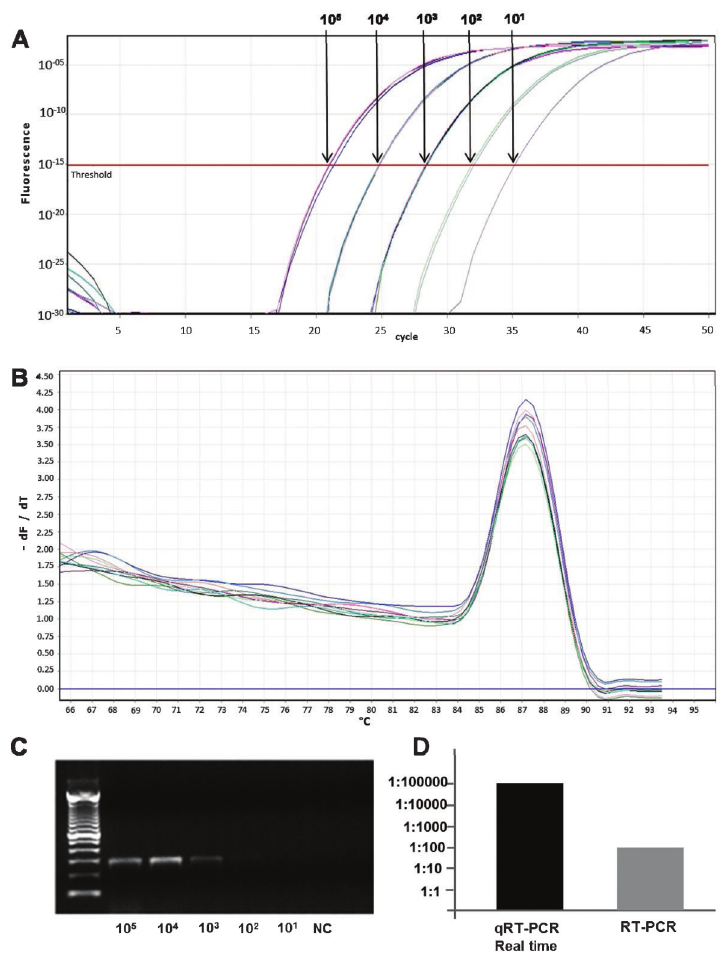
Figure 5. Comparison of the detection limit of alpha smooth muscle actin ( a -SMA) cDNA using semiquantitative PCR (RT-PCR) and quantitative real-time PCR (qRT-PCR). cDNA from all of the samples was 10-fold serially diluted. A , Amplification curve generated by plotting SYBR Green I fluorescence data (y-axis) collected at each cycle (x-axis) during the extension phase of the PCR. cDNA copy number per sample: (10 5 , 10 4 , 10 3 , 10 2 , 10 1 ). B , Melting curve analysis obtained by plotting the negative derivative of fluorescence over temperature (-dF/dT) (y-axis) vs temperature in degrees Celsius ( 6 C) (x-axis) showing the specificity of the PCR assay for samples with a small amount of genetic material. C , Samples amplified using RT-PCR and ana- lyzed with gel electrophoresis. Note that only three dilutions of cDNA were detected (10 5 , 10 4 , 10 3 ). D , Graphical representation of the detection efficiency of the diluted samples by the methods of RT-PCR and qRT-PCR. NC: negative